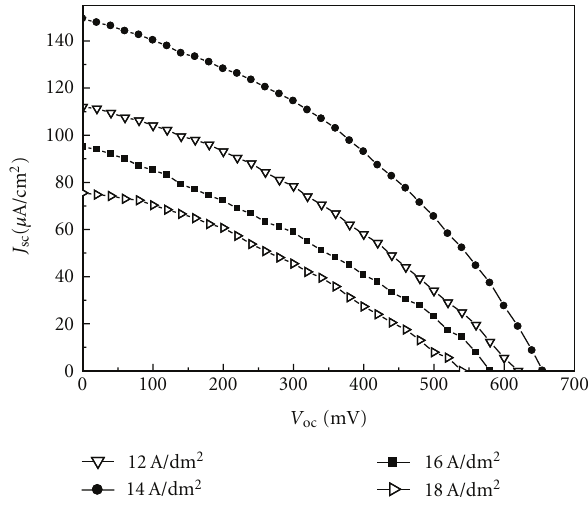
Figure 1: Results from I–V characteristics of TiO 2 electrodes pre- pared at di ff erent current density.